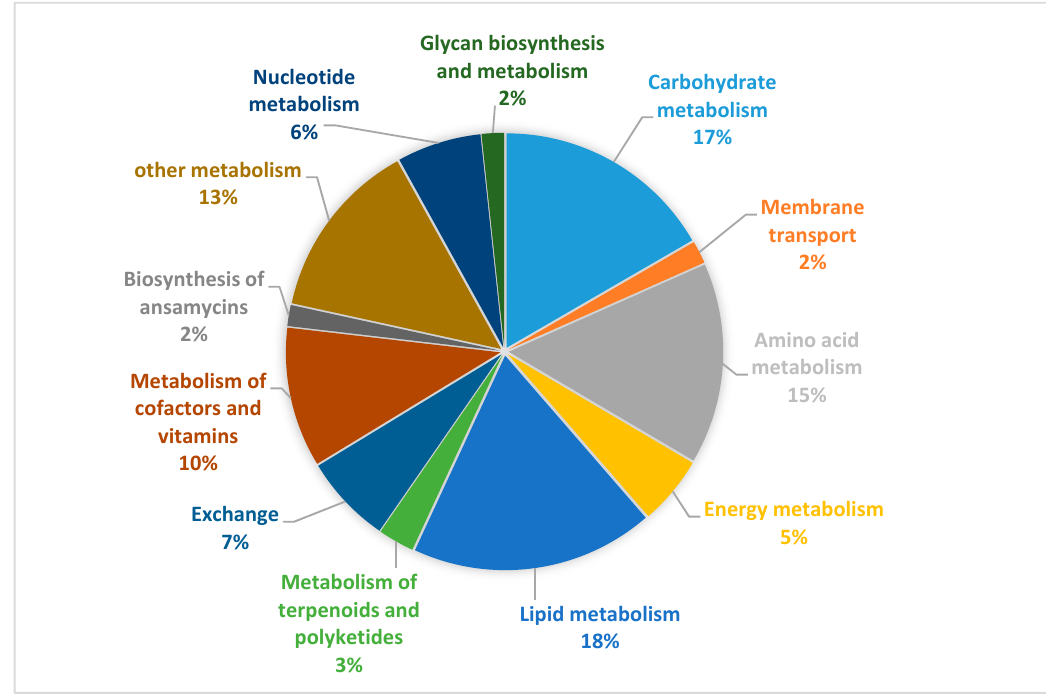
Figure 2. Percentage of reactions in each subsystem in Aspm1282 model.